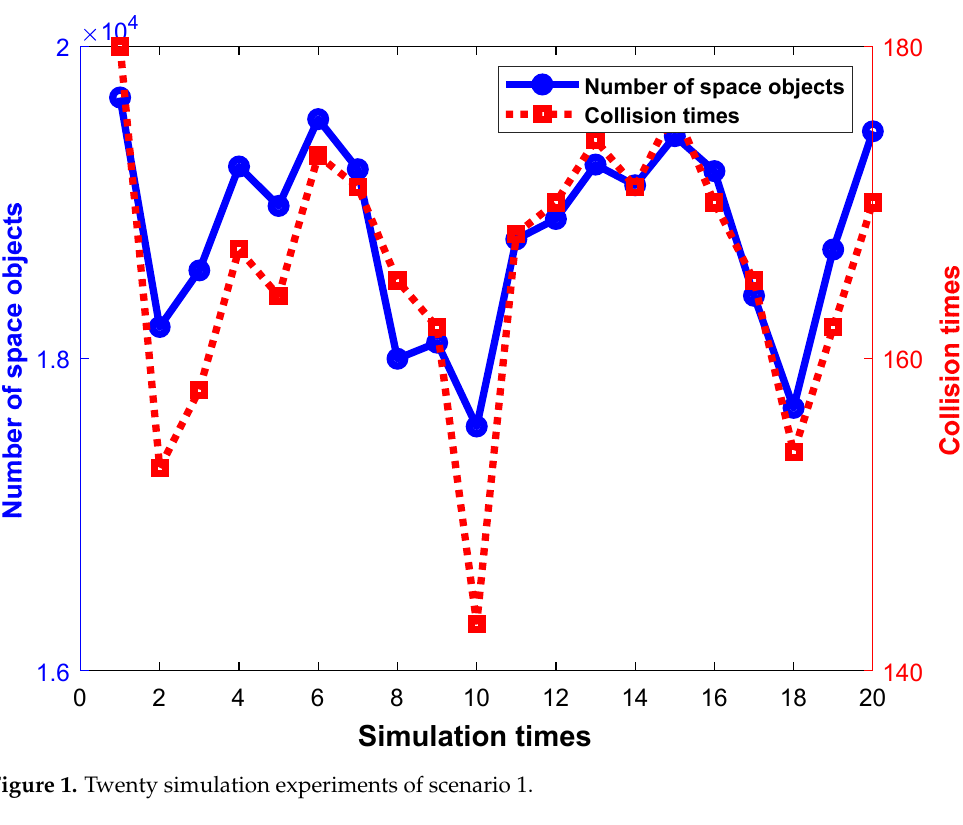
Figure 1. Twenty simulation experiments of scenario 1. The simulations with the largest and smallest numbers of space objects after 100 years in this scenario are shown as Figure 2. The red dotted lines represent the total number of collisions since the first collision at 0:00 on 1 February 2022, and the blue solid lines rep- resent the number of space objects larger than 0.05 m in the GEO band.